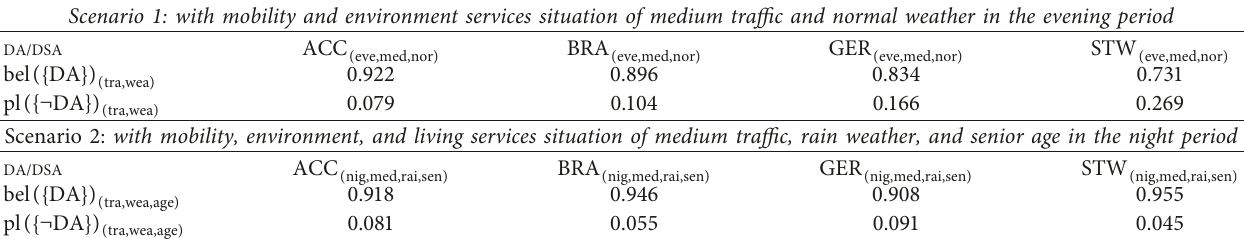
Table 5: Belief values of DA with one activated sensor combined with different services in different